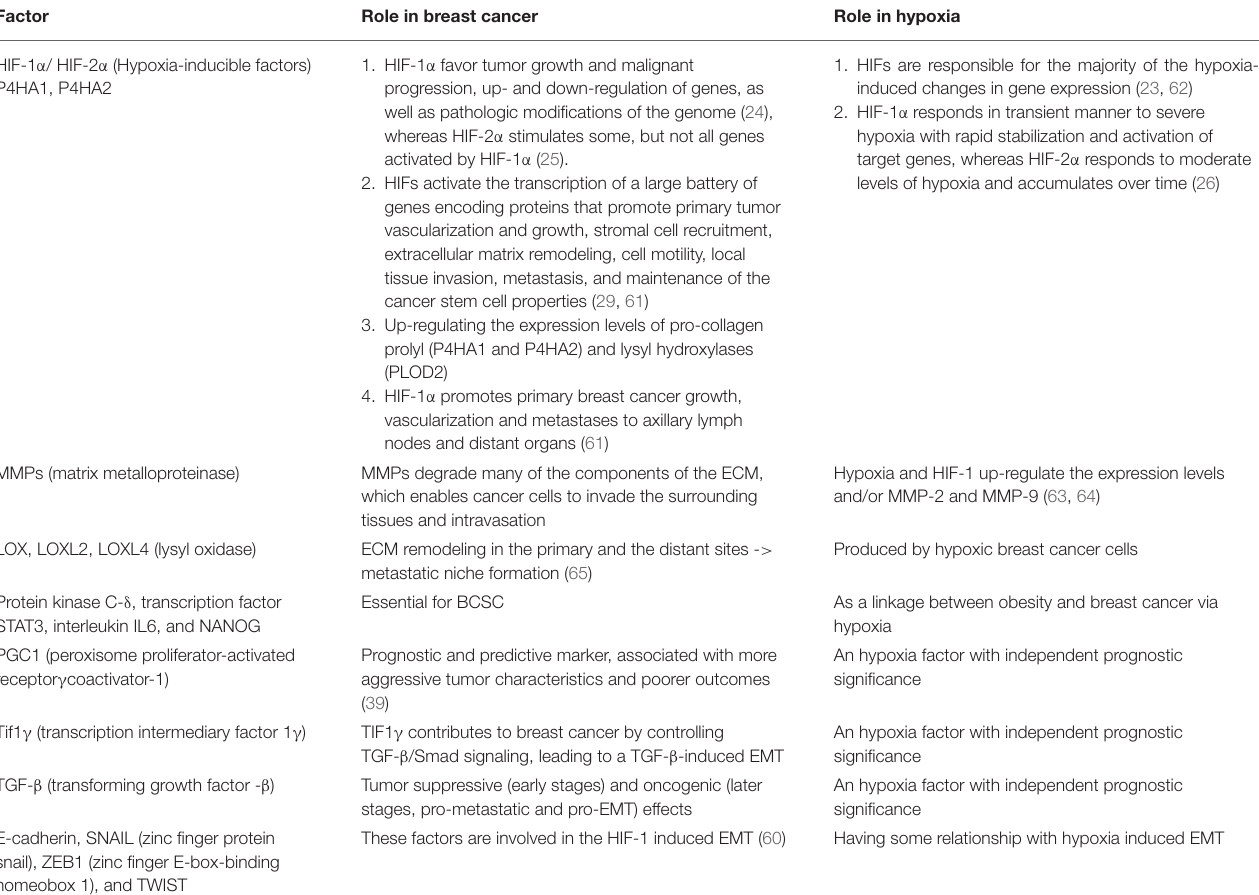
TABLE 1 | Role of various factors in breast cancer and hypoxia. Factor Role in breast cancer Role in